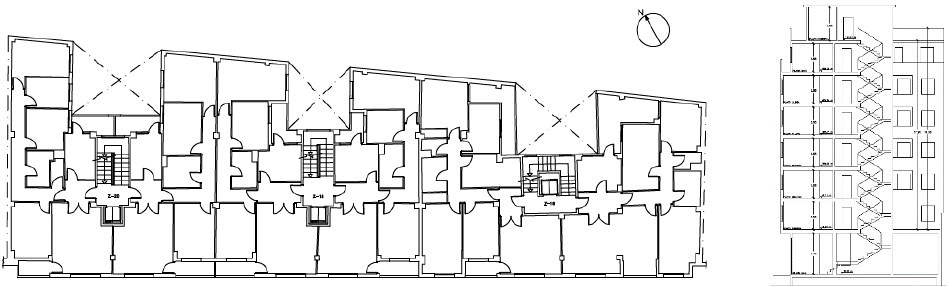
Figure 4. Main floor plan ( left ) and section ( right ) of the building in its current state.